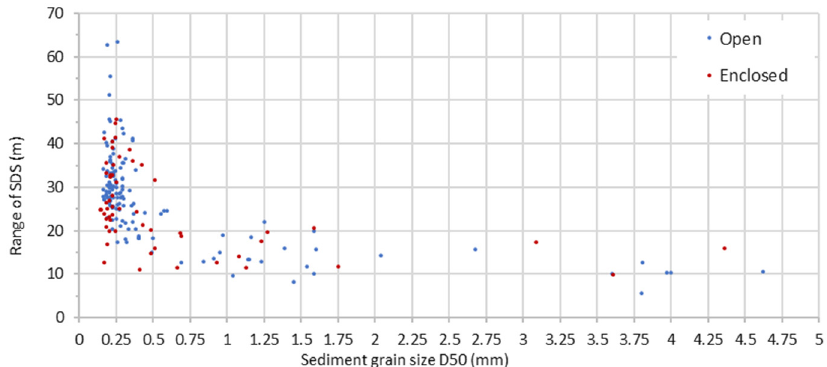
Figure 8. Grain size of the sediment sample expressed as D 50 versus the variability of the shoreline position expressed as the range between the most landward and seaward SDS included in a 100 m buffer. Samples appear classified as open beaches (blue) and enclosed beaches (red).